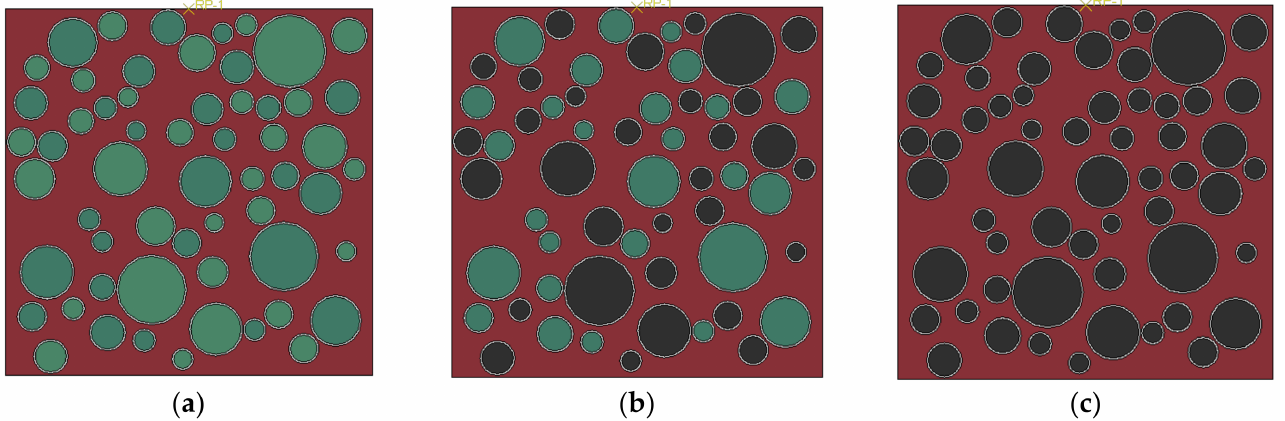
Figure 10. Two-dimensional finite elementmodel (Note: ( c )